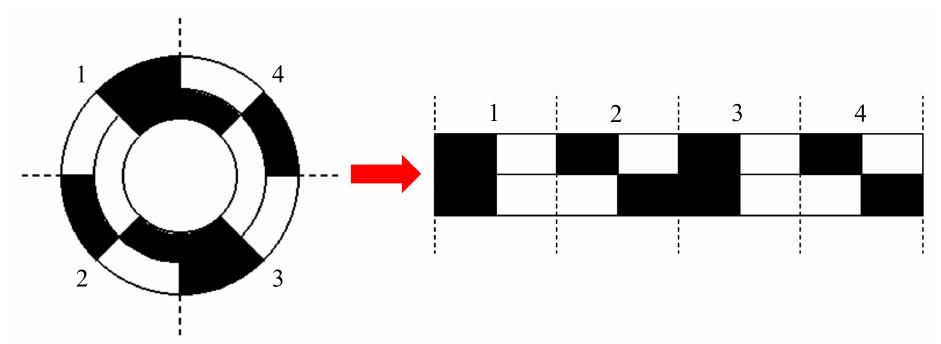
Figure 3. Alnicos with the same position relationship.